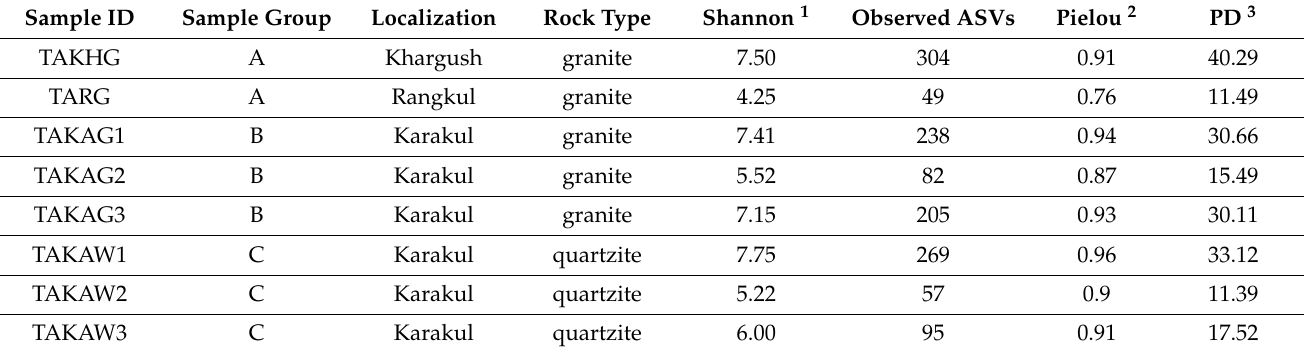
Table 1. Alpha-diversity metrics calculated for studied endolithic